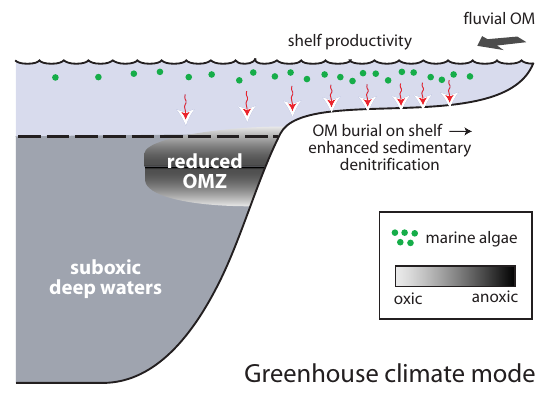
DevonCenoz Cretac Juras Trias Perm Pn Miss Sil Ord Camb 0 Figure 10 Fig. 10. Comparison of secular variation in δ 15 N sed with Phanero- zoic eustatic and continental flooding records. (a) δ 15 N sed data from Fig. 1. (b) Eustatic data from Haq and Al-Qahtani (2005) and Haq and Schutter (2008) as given in Snedden and Liu (2010). (c) Continental flooding data from Sloss (1963) and Ronov (1984) as given in Miller et al. (2005). Phanerozoic climate modes at top are from Fig. 1; all ages have been adjusted to the Gradstein et al. (2012) timescale. Tr = transitional